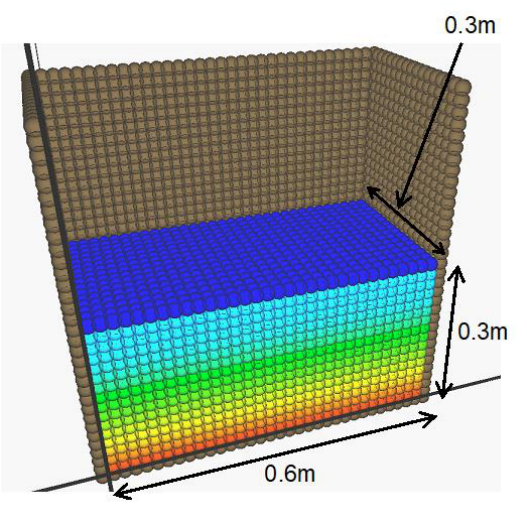
Fig. 9. Initial particle arrangement for still water